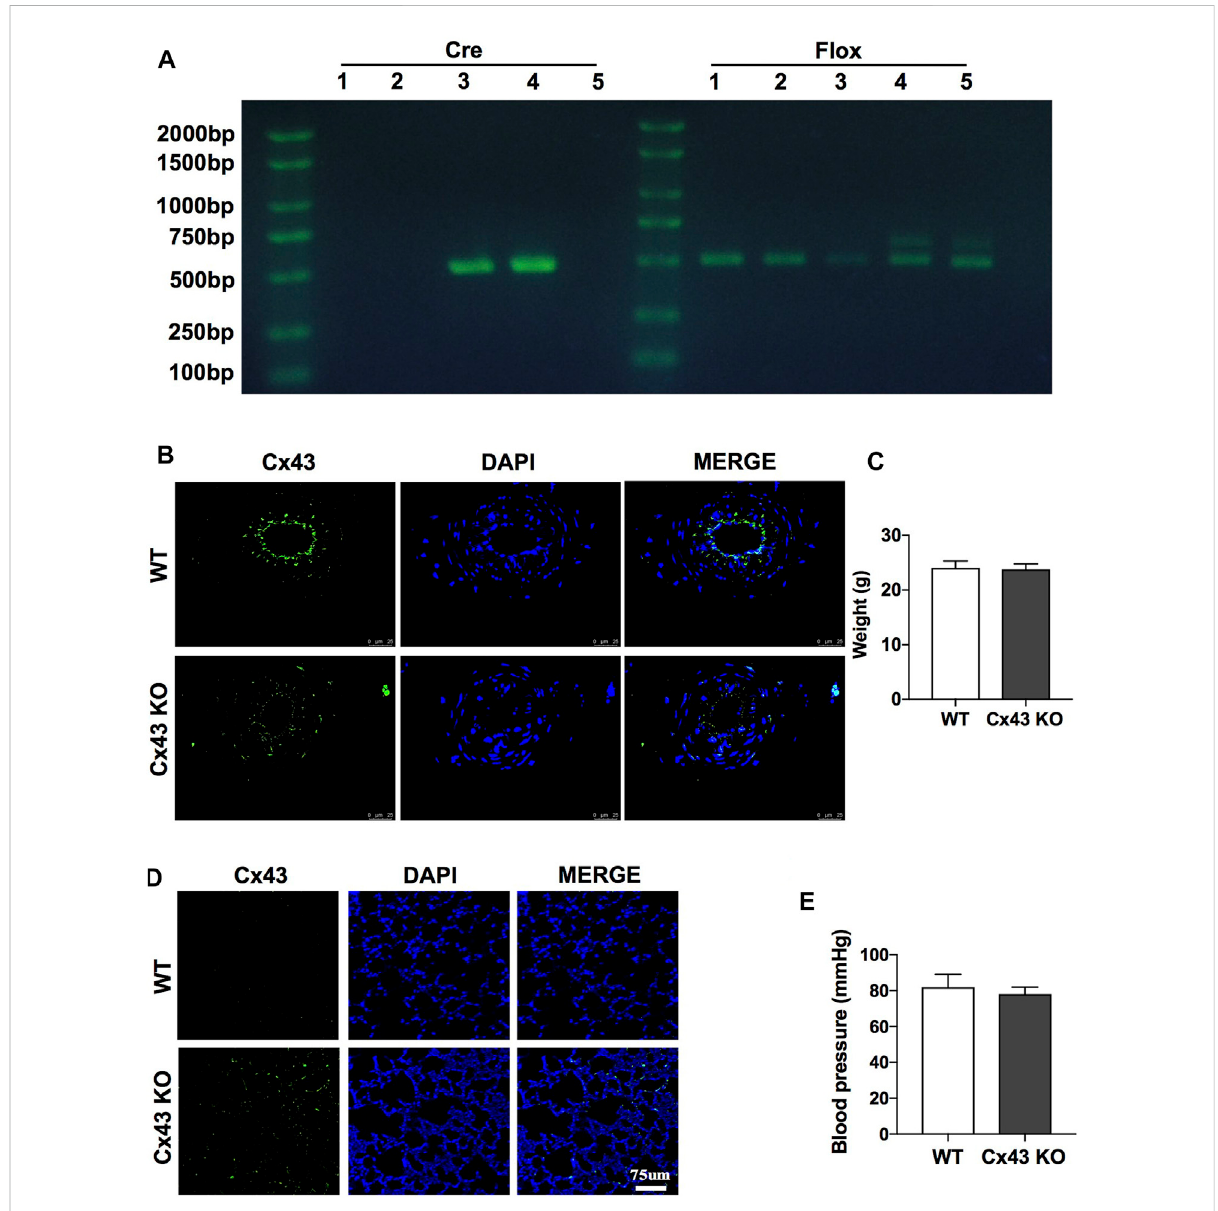
FIGURE 6 Veri fi cation of VEC-speci fi c Cx43 knockdown (VEC Cx43 KO) mice. (A) Genomic identi fi cation. (B) Expression of Cx43 in VECs observed by immuno fl uorescence ( n = 8). (C) Weight of WT and Cx43 KO mice under normal conditions ( n = 8). (D) Changes of pulmonary vascular permeability in mice ( n = 8). (E) Blood pressure and weight of WT and Cx43 KO mice under normal conditions ( n =